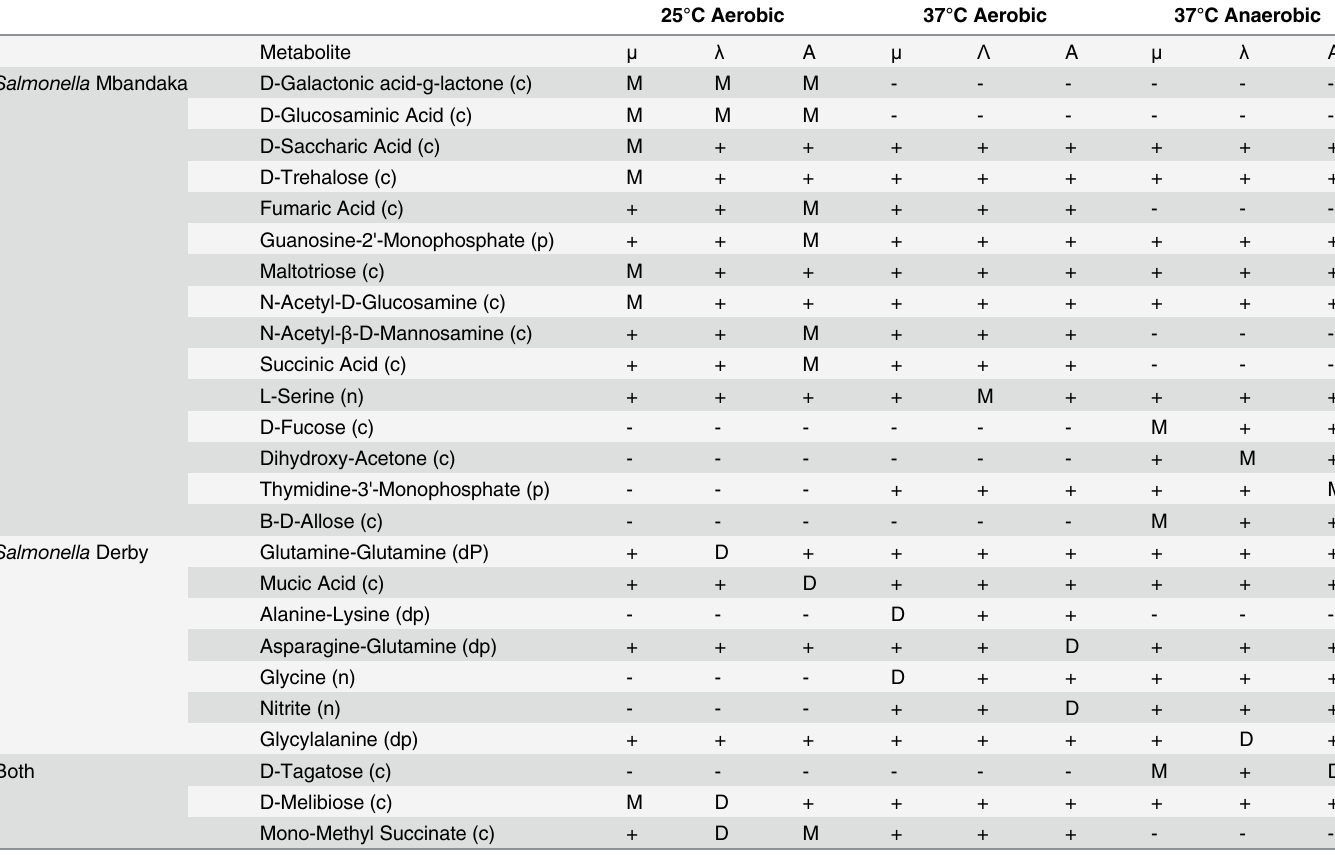
Table 1. Summary of significant differences in respiratory parameters between S . Derby and S .